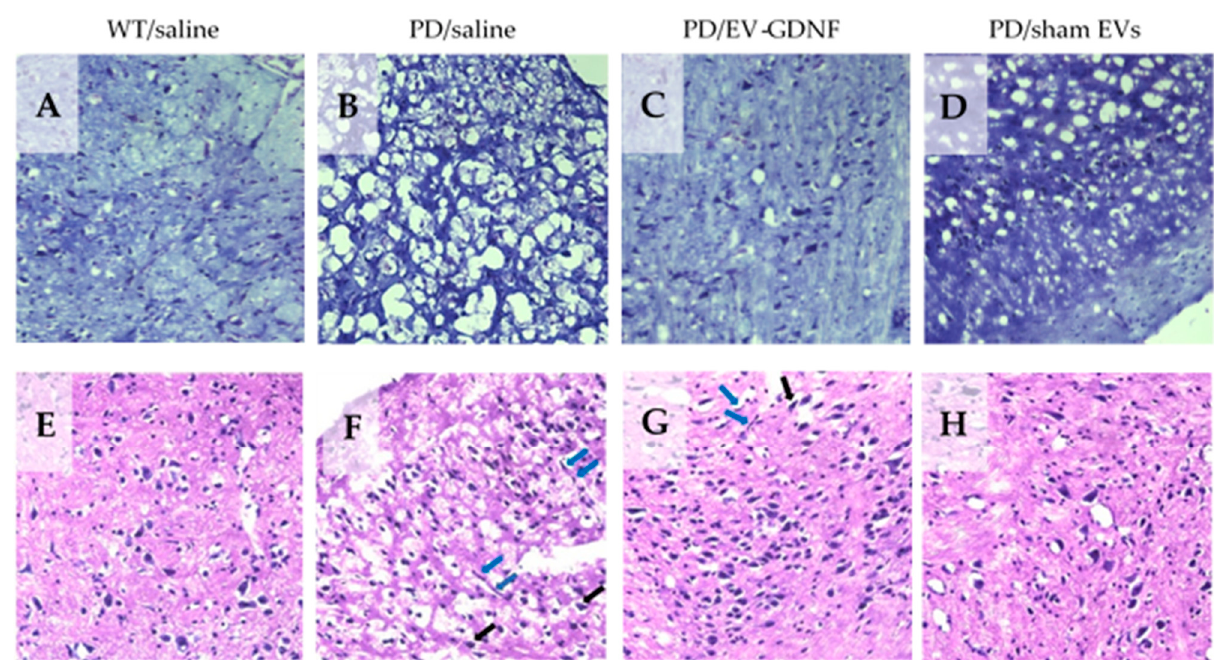
Figure 6. Histological analysis of neuroprotective effects of EV-GDNF in Parkin Q311(X)A mice. Transgenic mice (4 mo old) were intranasally injected with: saline (10 µL/mouse), ( 3 ) EV-GDNF (3 × 10 9 particles/10 µL/mouse), or sham EVs (3 × 10 9 particles/10 µL/mouse). Wild-type control mice were intranasally injected with saline (10 µL/mouse). Animals were sacrificed at month 16, and brain slides were stained with Nissl staining ( A – D ) or H&E staining ( E – H ). The obtained bright-light images show lower numbers of Nissl bodies with neuronal shrinkage ( B ) and damaged tissues with degeneration in the neurons ( F ) in PD mice treated with saline when compared to WT mice ( A , E ). Histological analysis indicates neuroprotective effects in the brain of PD mice treated with EV-GDNF with healthy morphology in tissue structure and high integrity of neurons ( C , G ) when comparted to PD mice treated with saline ( B , F ). The administration of sham EVs did not have a significant therapeutic effect in PD mice ( D , H ). Black arrows, degenerated neurons; blue arrows, elongated irregular nuclear morphology.